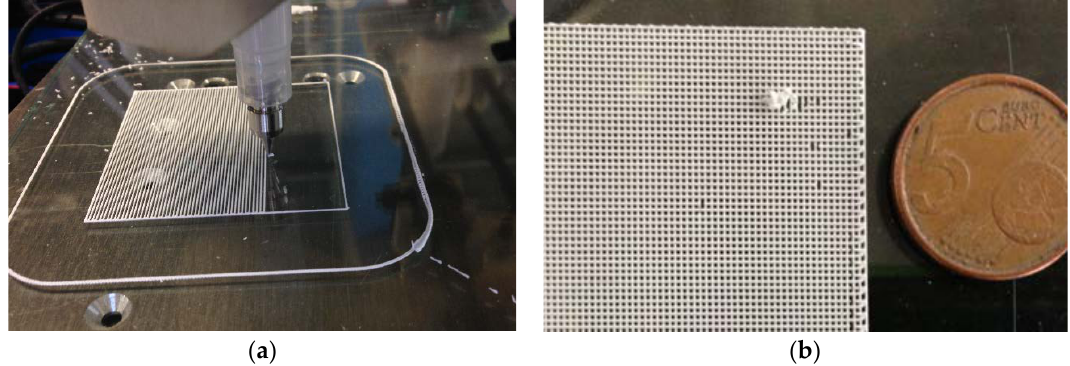
Figure 3. Exemplary images: ( a ) Robocasting system 3D printing the first layer of a squared ceramic mesh; ( b ) Detail of a thin 3D printed ceramic mesh composed of two layers of